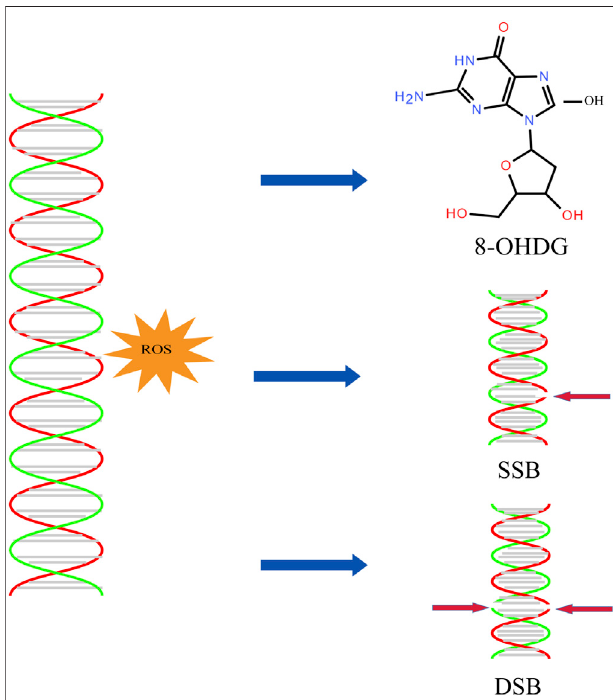
FIGURE 3 | DNA oxidative damage. ROS can induce the production of 8-OHDGandthebreakageofsinglestrandedDNAanddoublestrandedDNA.